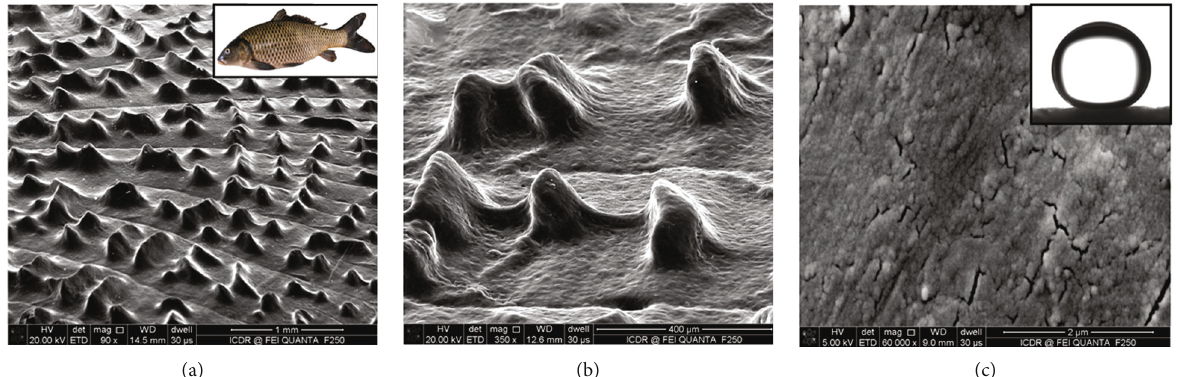
Figure 17: Scanning electron microscope (SEM) image of fi sh scale surface. (c) Inset is oil droplet [85].